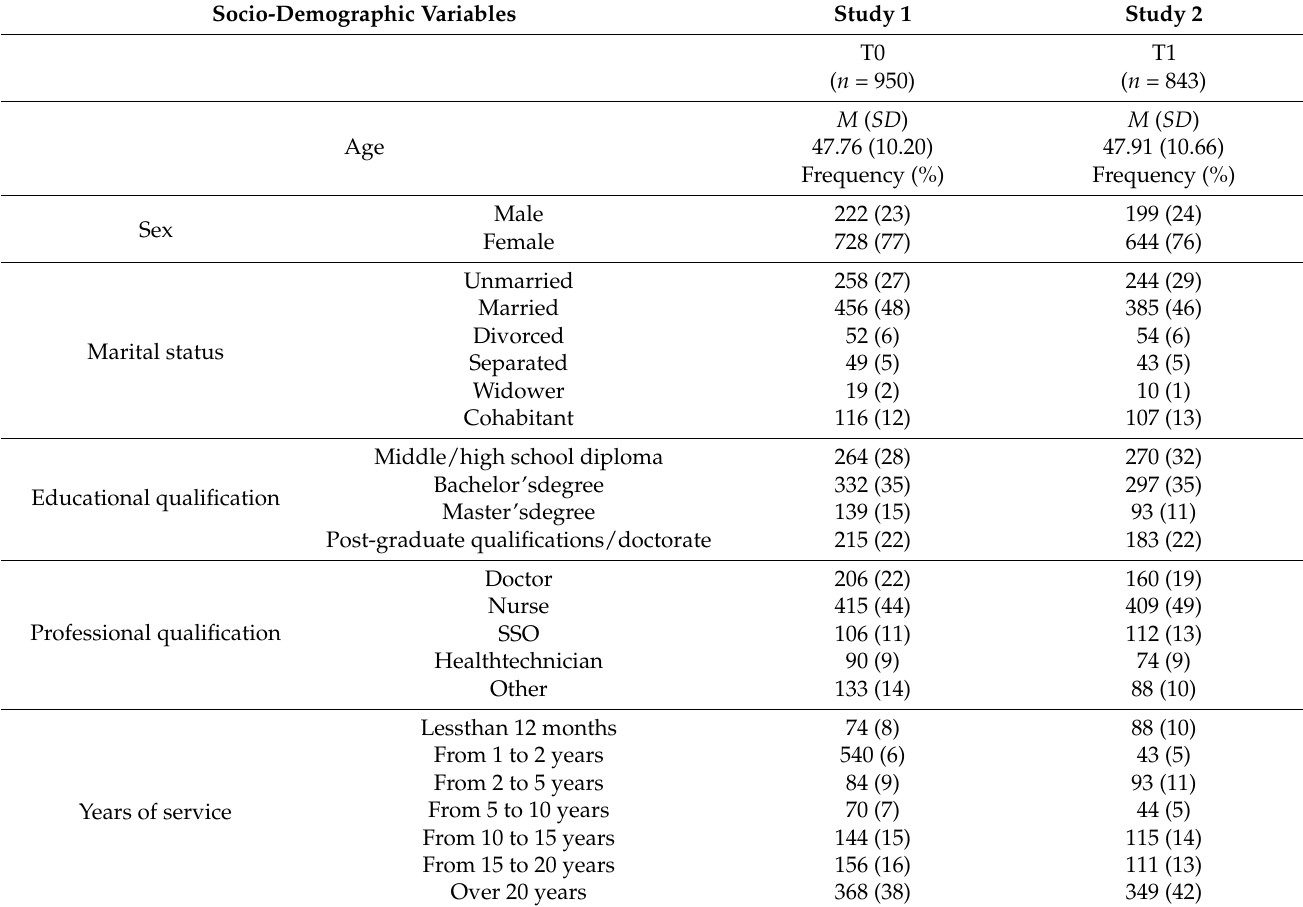
Table 2. Socio-demographic variables of three groups of participants in two different surveys (T0 and